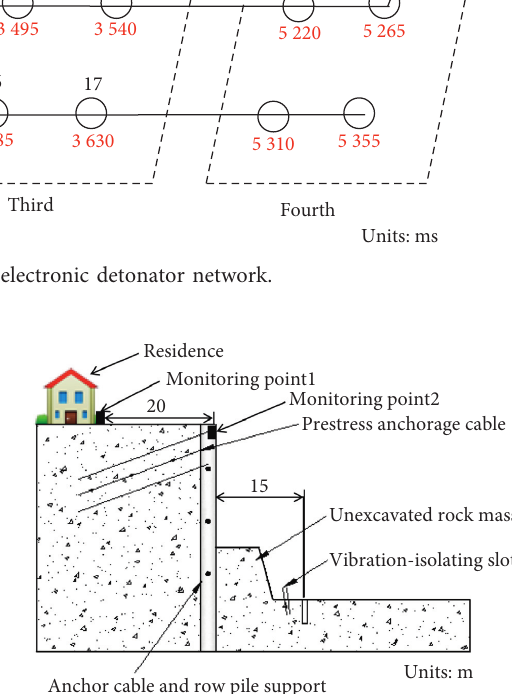
Figure 3: Schematic of the monitoring